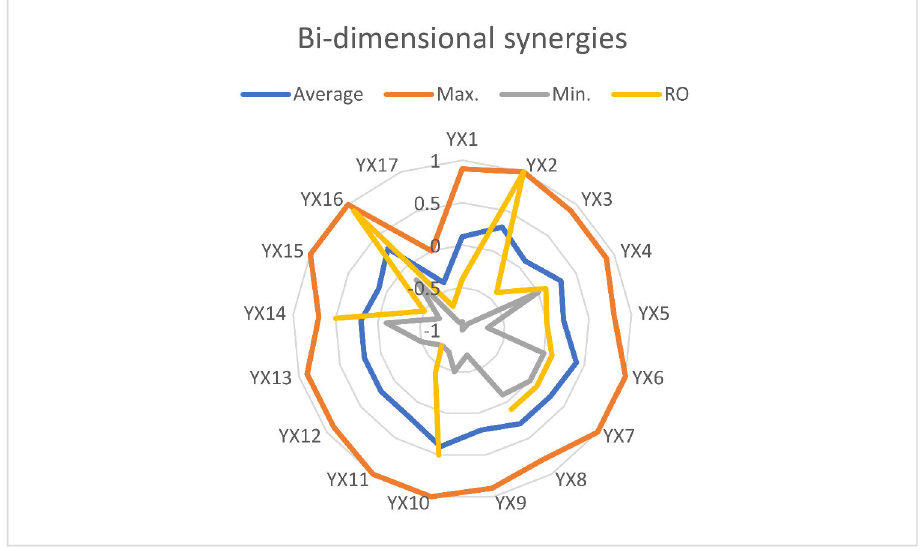
Figure 4. Bi-dimensional synergies between renewable energy share of final consumption versus R&D, patents, training, employment, wealth, and emissions. Source: Authors’